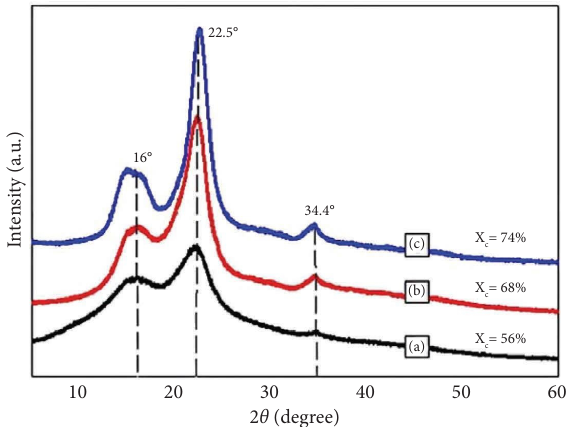
Figure 6: XRD difractogram of (a) groundnut shell (GNS) with percentage crystallinity ( X c ) was 56%, (b) groundnut shell chem- ically purifed cellulose (CPC-GNS) with X c was 68%, and (c) groundnut shell cellulose nanocrystal (CNC-GNS) has the highest X c among the other treatments which were 74% [11]. Copyright and permission from